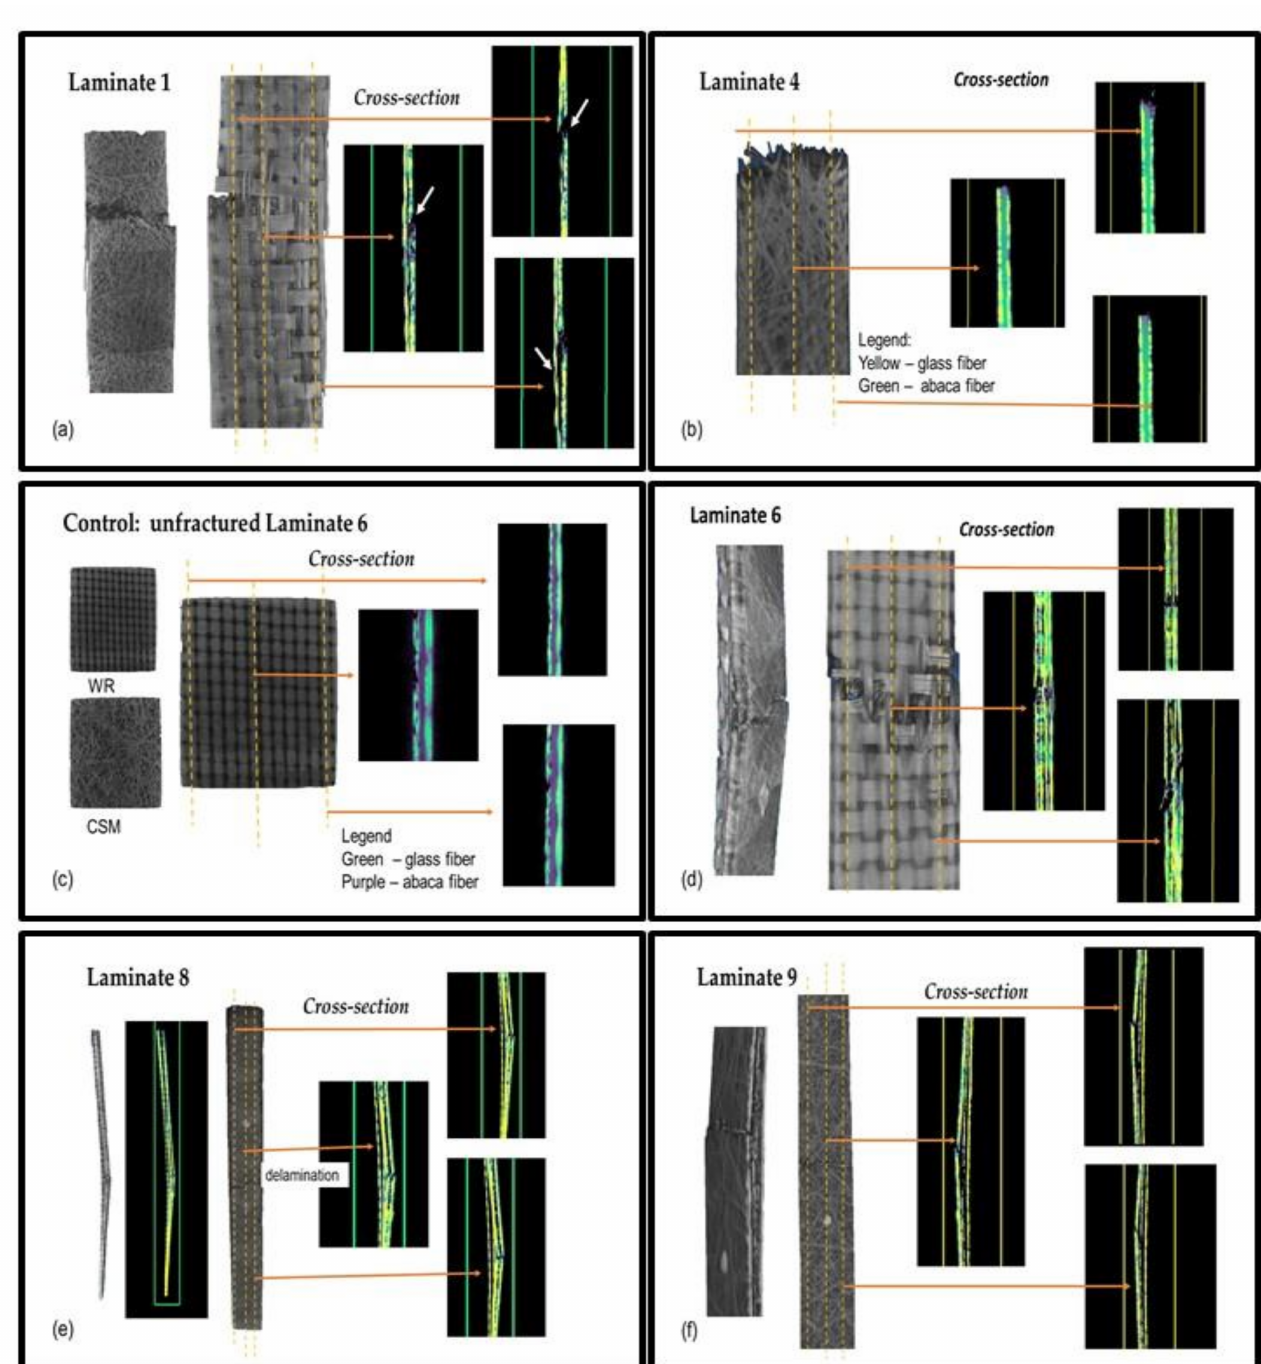
Figure 5. X-ray Computed Tomography images of the cross section of tensile fractures of the laminated samples ( a ) laminate 1, ( b ) laminate 4, ( c ) control-unfractured laminate 6, ( d ) laminate 6, ( e ) laminate 8, and ( f ) laminate